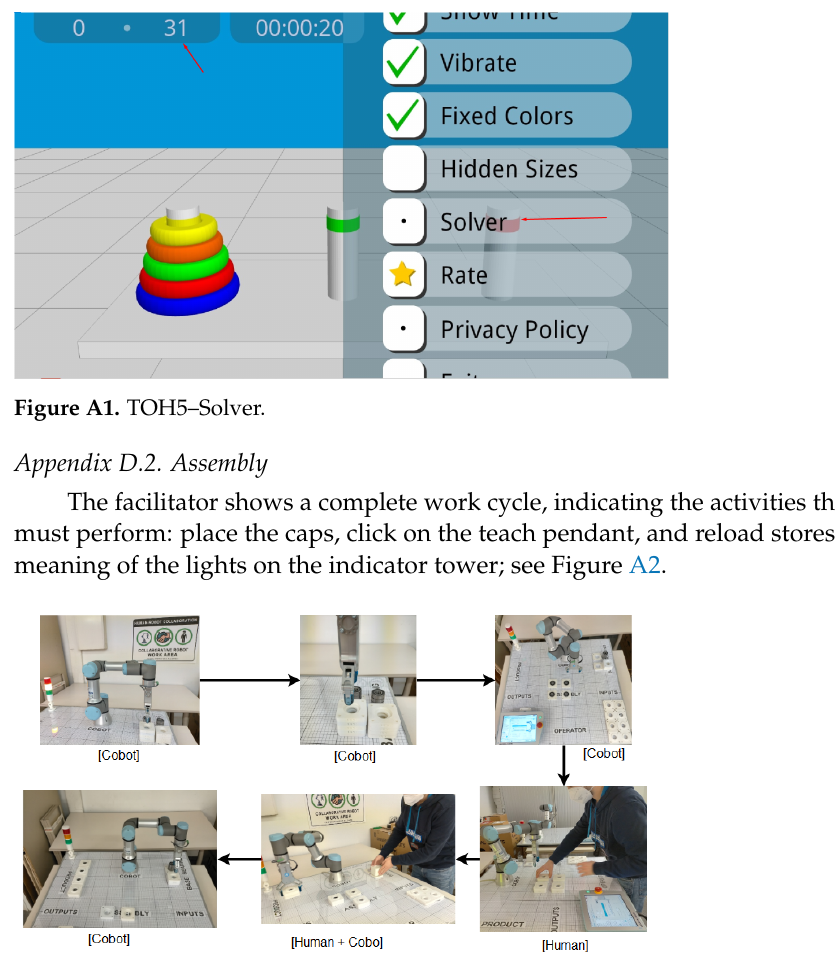
Figure A2. Demonstration assembly cycle work